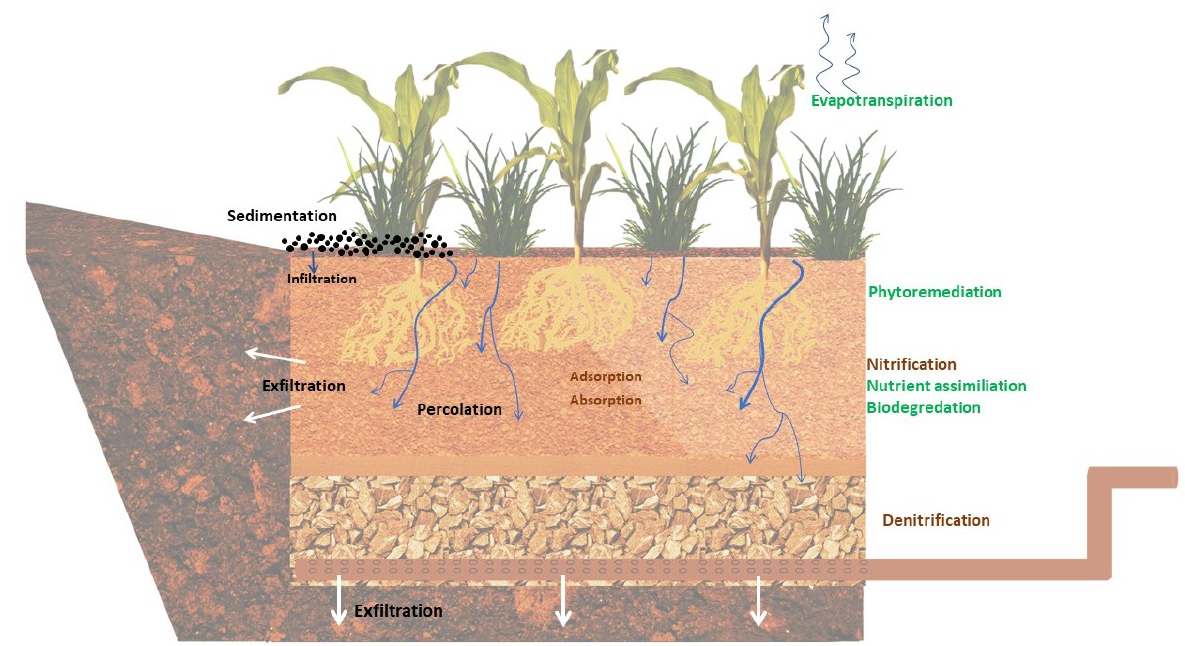
Figure 3. Fundamental physical (black label), biochemical/chemical (brown label), and biological (green label) mechanisms that occur in BRCs. Infiltration/percolation (blue arrows) and exfiltration (white arrows) are